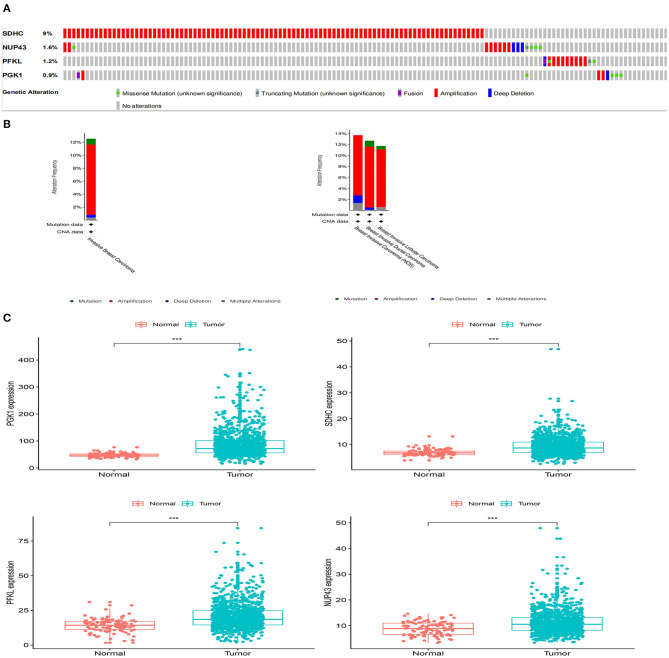
Gene mutation overview of four genes. (A) The four genes were altered in 125 (12.55%) of the 996 patients. (B) Specific alteration of selected genes in different pathological types of BRCA. (C) Differential expression analysis of the four selected genes.